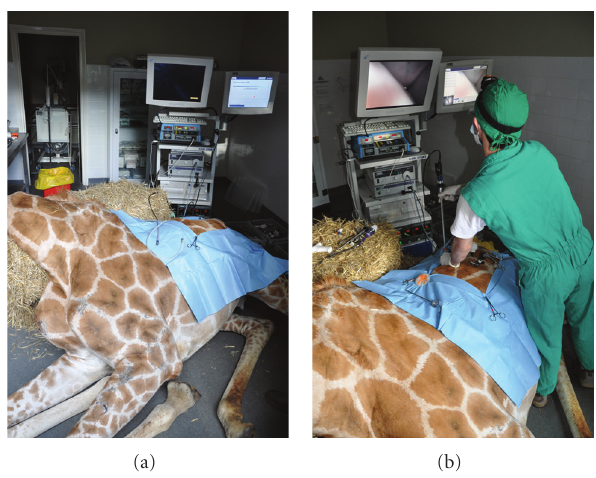
Figure 1: Positioning of the gira ff e postmortem and the laparoscopy stack for the left flank laparoscopic approach.